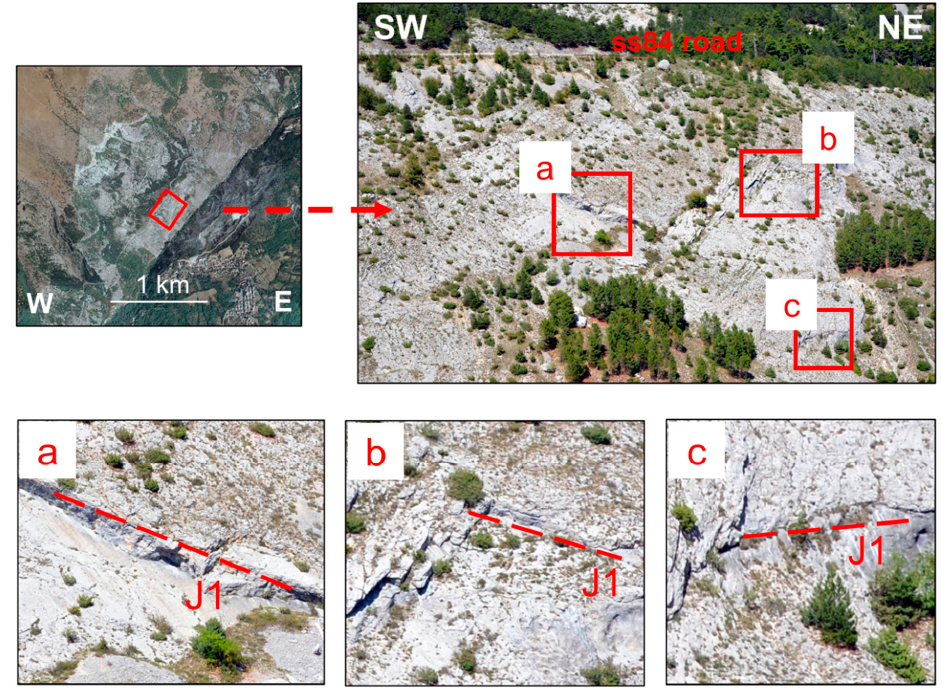
Figure 16. Topography of the analysed slope at the toe showing the scar of a step-path failure constrained by multiple bedding planes and joints related to J1.